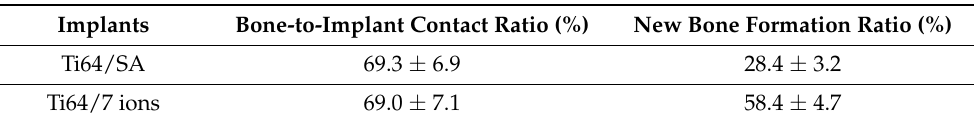
Figure 7. Histological images of tissue 8 weeks after implantation showing no signs of inflammation at the bone–implant interface where ( a ) Ti64/SA implants and ( b ) Ti64/7 ion implants are used. These images were observed after removing the implant from rabbits. By observing the tissue images of Ti64/SA and Ti64/7 ion implants, it can be seen that the dense bone in ( b ) is well-formed. The black part is judged as marrow, and the red represents bone. ( c , d ) represent the amount of newly formed bone around the surfaces of Ti64/SA and Ti64/7 ion implants, respectively. From high-magnification images shown as insets, the Ti64/7 ion implants were found to exhibit greater amounts of newly formed bone from original cortical bone compared with the Ti64/SA implants. Table 2. Average bone-to-implant contact area (BIC) ratio and new bone formation rate measured in Ti64/SA and Ti64/7 ion implants.